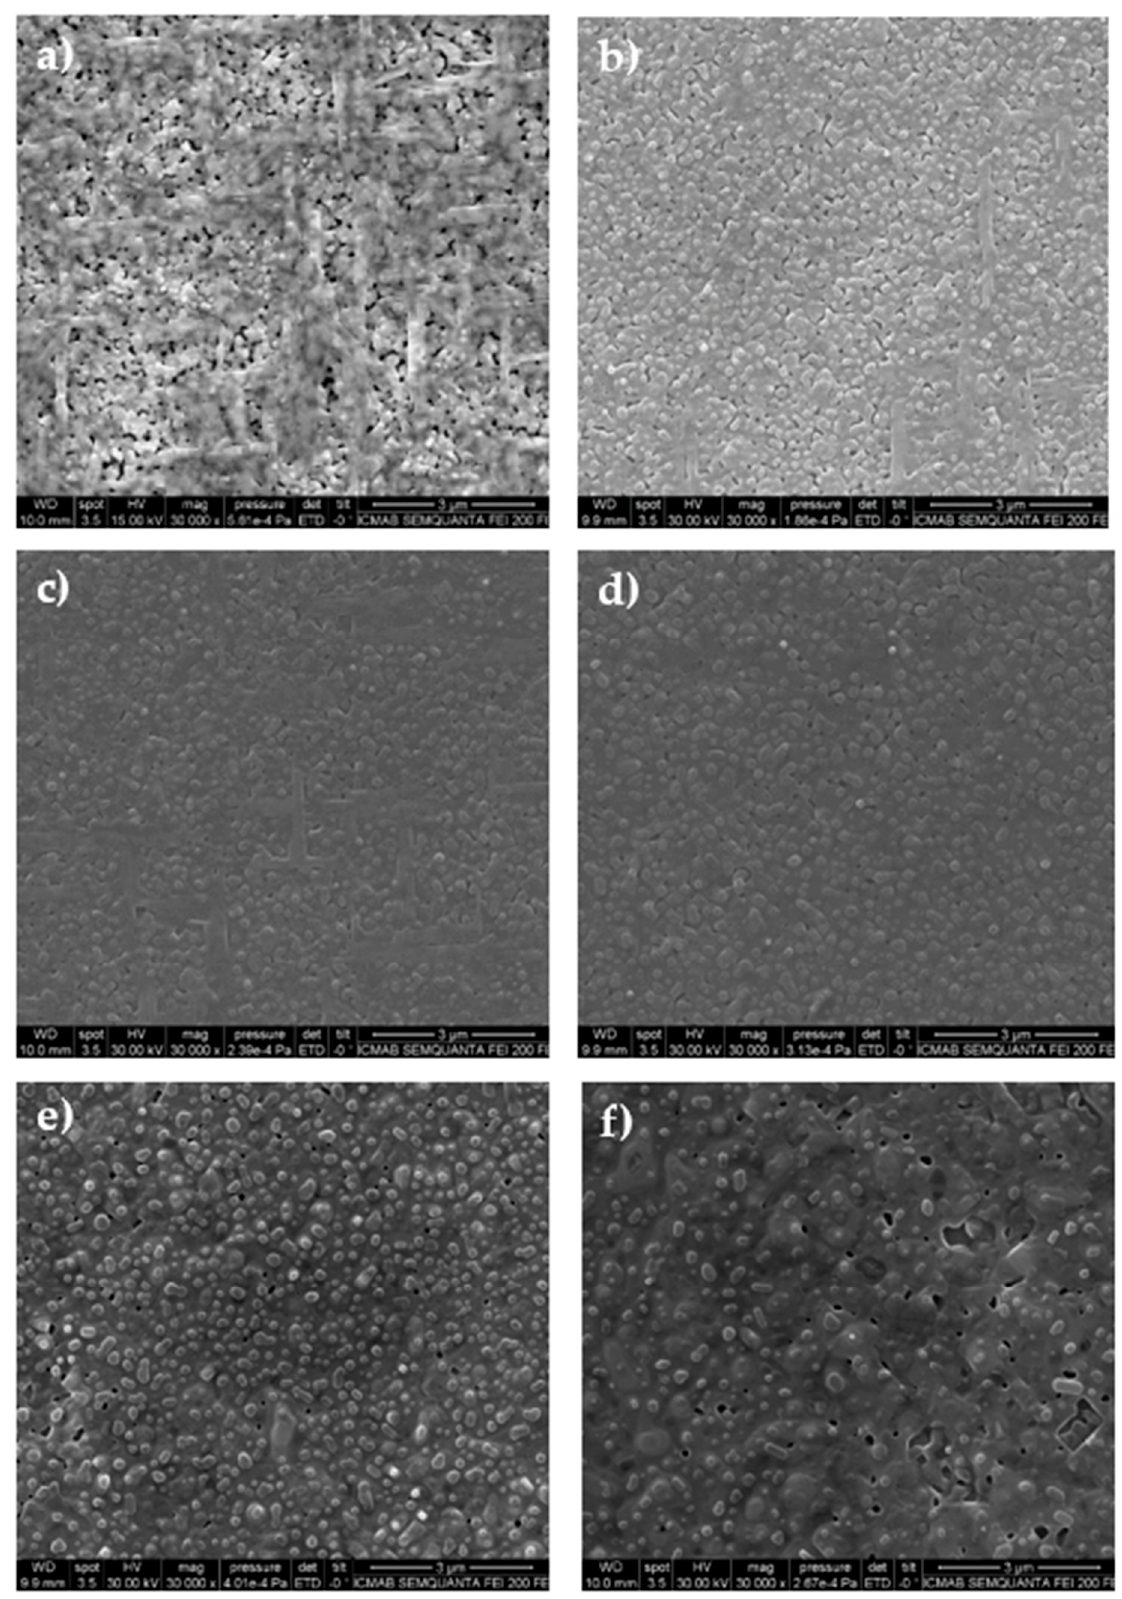
Figure 2. SEM images of different samples grown with the flash heating (FH) method at: ( a ) 700, ( b ) 720, ( c ) 730, ( d ) 750, ( e ) 780 and ( f ) 810 °C.